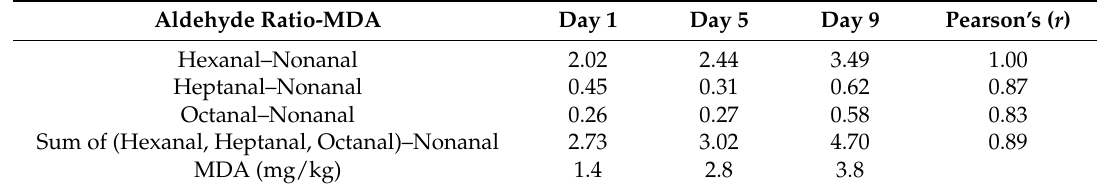
Table 2. Aldehyde ratios and malonic dialdehyde development with respect to storage time (days). Aldehyde